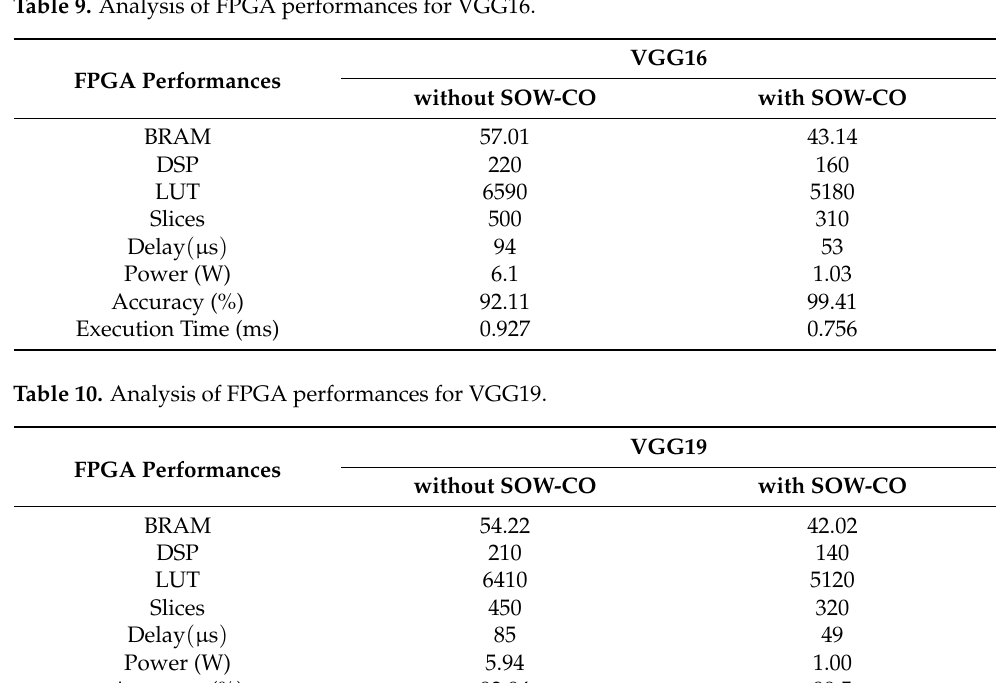
Table 9. Analysis of FPGA performances for VGG16.